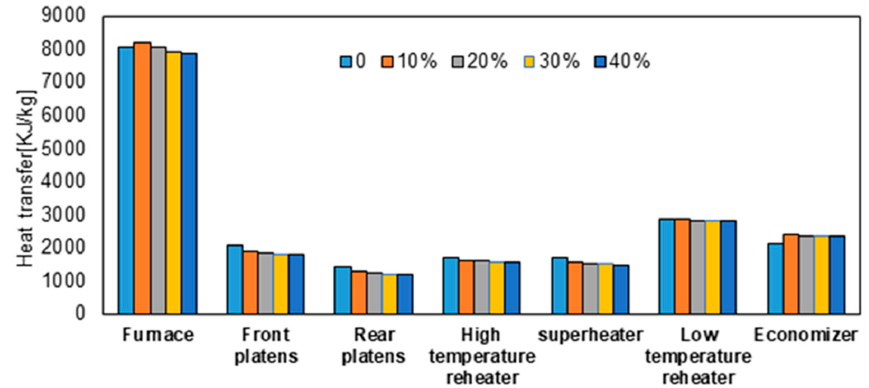
Figure 7. Effect of co-firing on heat transfer in boiler furnace and to heat exchangers.